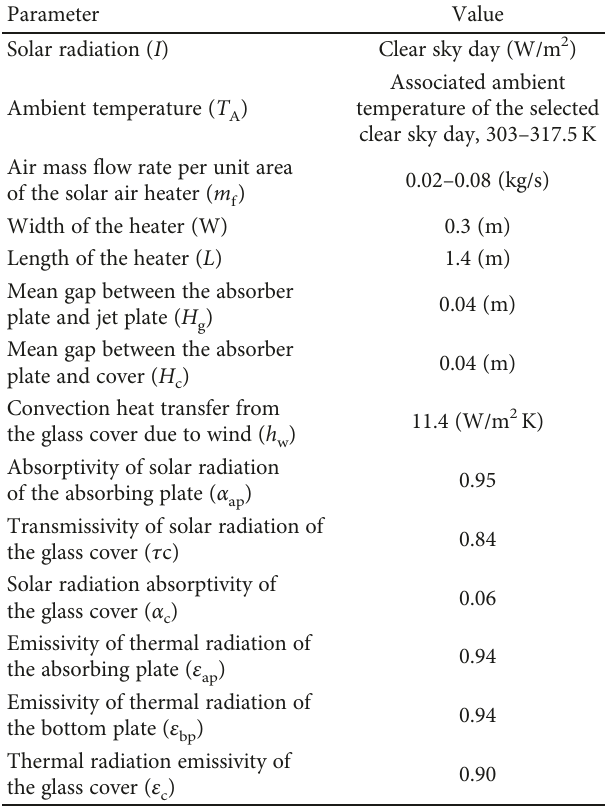
Table 3: Working conditions and assumptions used in evaluating the potential of the proposed design.